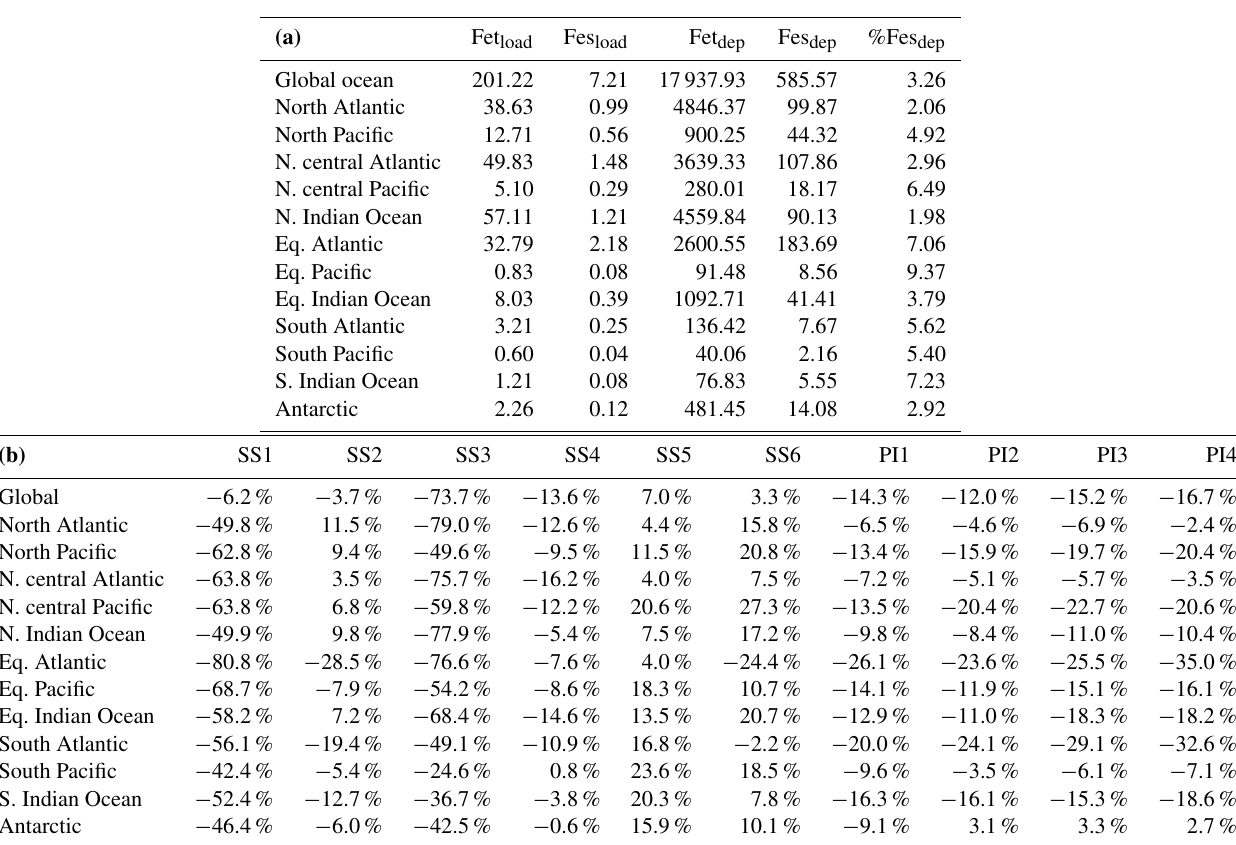
Table 6. (a) Annually averaged loading (Gg), deposition (Ggyr − 1 ) and fractional iron solubility at deposition to global and regional oceans for the reference case. (b) Percent change for all cases relative to the reference case for global and regional fractional iron solubility at deposition to the ocean.